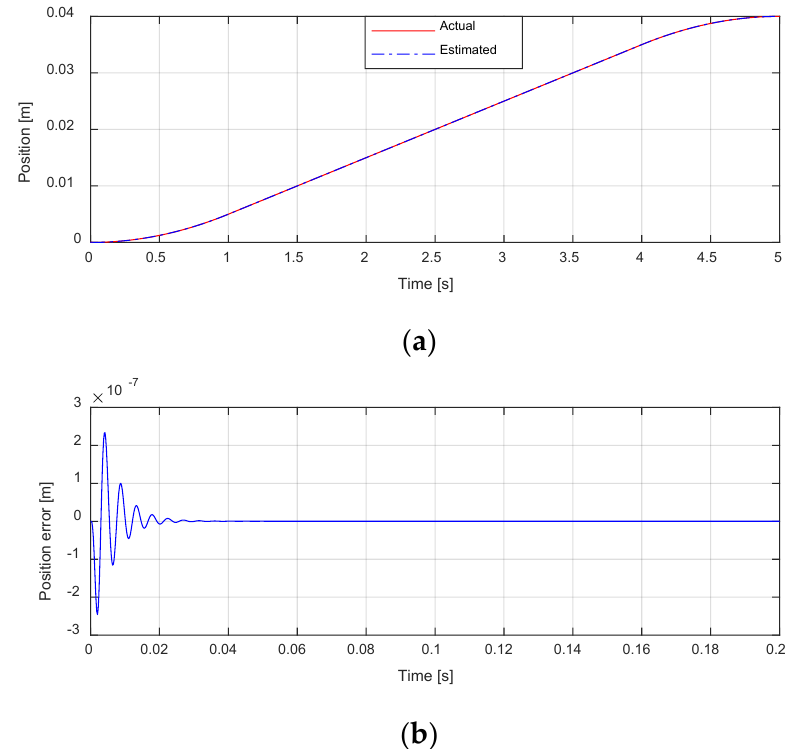
Figure 4. Estimation performance of X − axis. ( a ) Estimation performance of θ x and ˆ θ x . ( b ) (cid:101) θ x estimation